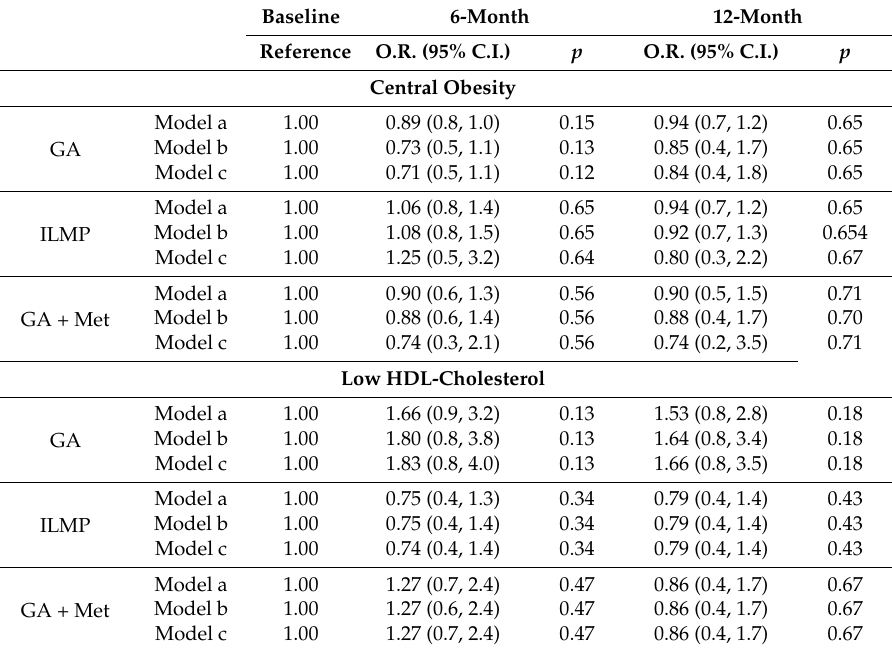
Table 3. Odds ratio representing the risk of having MetS and its individual components at follow-up compared to baseline in respective